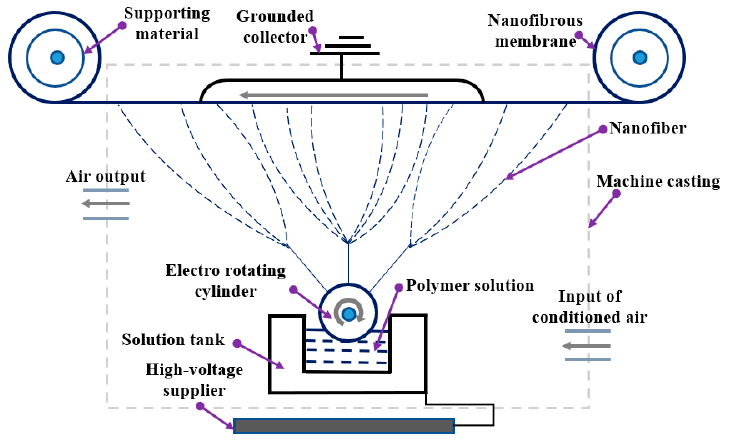
Figure 2. Schematic diagram of the electrospraying method (Nanospider).